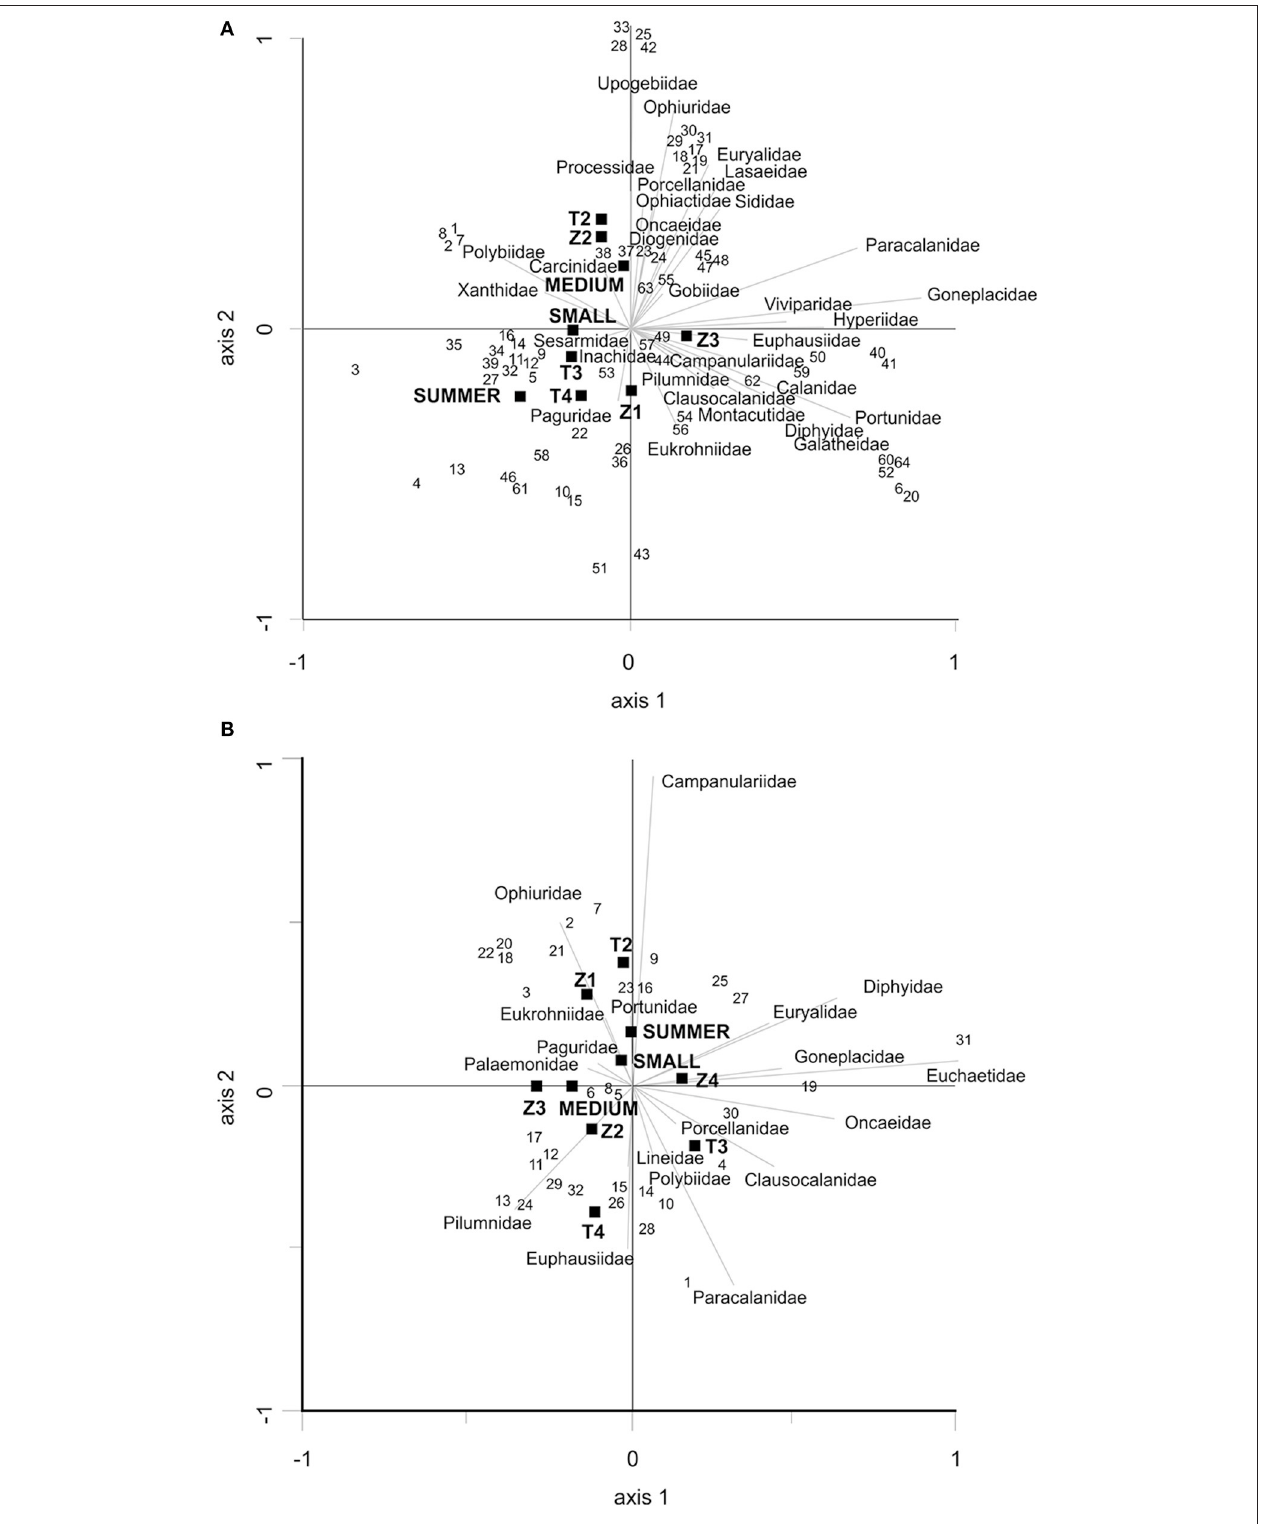
FIGURE 5 | (A) RDA triplot for the O. vulgaris families identified with COI gene. The correlation matrix was used. The first axis explains 29.57% and the second axis explains 21.96% of the total sum of all canonical eigenvalues (0.192). All the explanatory variables were used. (B) RDA triplot for the A. media families identified with COI gene. The correlation matrix was used. The first axis explains 27.26% and the second axis explains 21.47% of the total sum of all canonical eigenvalues (0.39). All the explanatory variables were used.